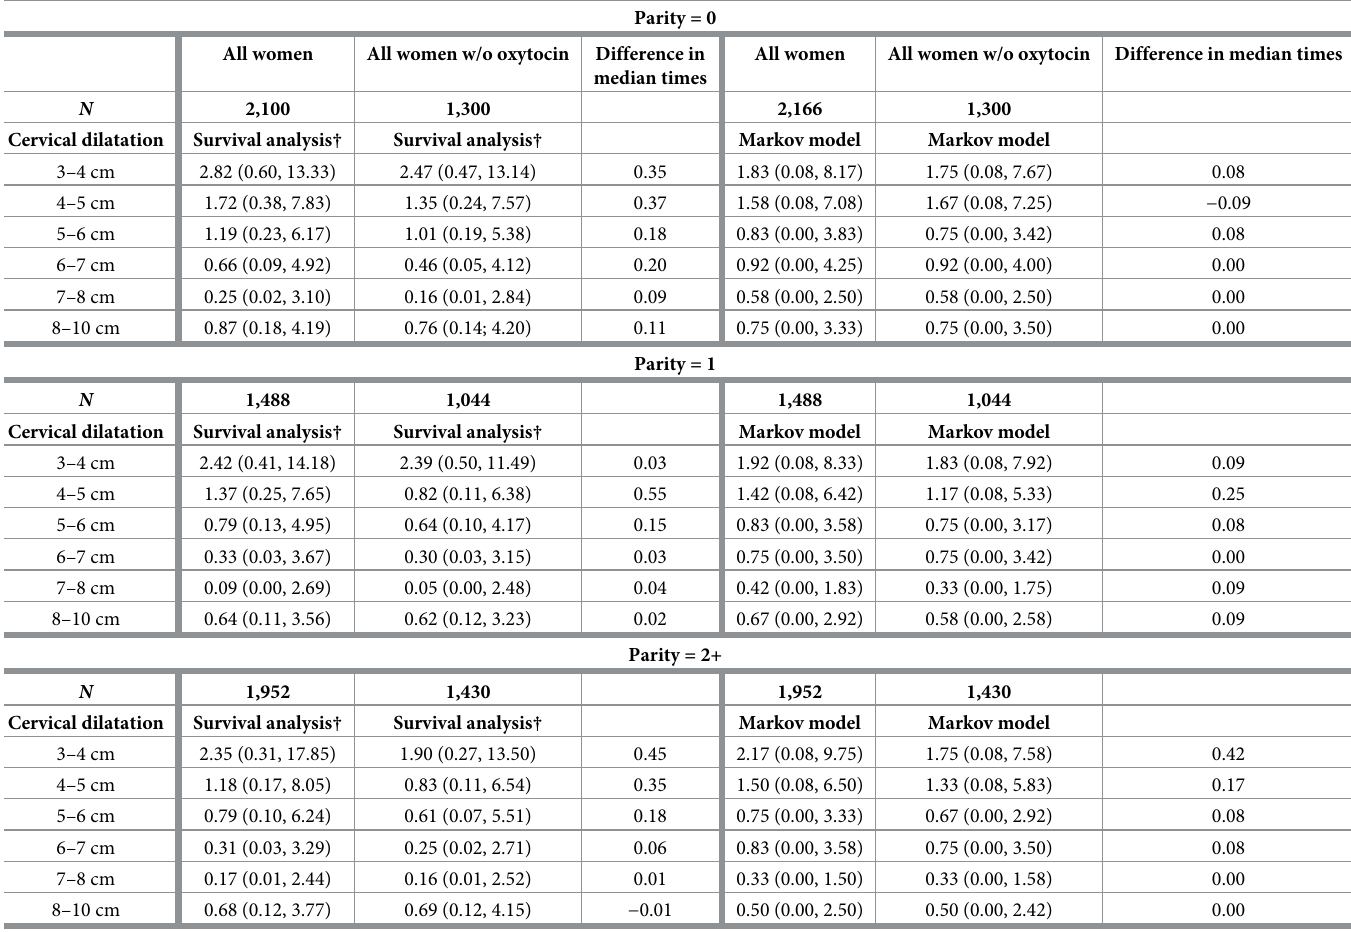
Table 4. Duration of labour from one level of cervical dilatation to the next with and without augmented